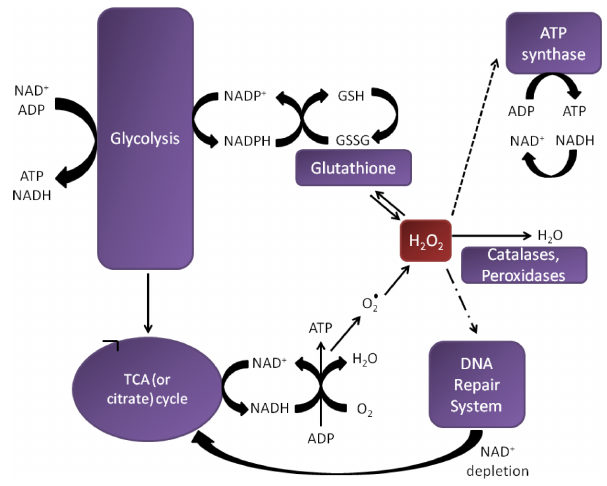
Figure 5. Hypothetical mechanism that could explain the im- pact of H 2 O 2 on cell metabolism and ATP concentration. Inter- connection between ATP synthesis and cellular redox potential (NAD + / NADH, NADP + / NADPH ratios). NAD + depletion re- lated to the DNA repair system. Adapted from Oka et al. (2012). - - - arrows: inhibition of ATP synthase; –.–.– arrows: NAD + de- pletion related to the DNA repair